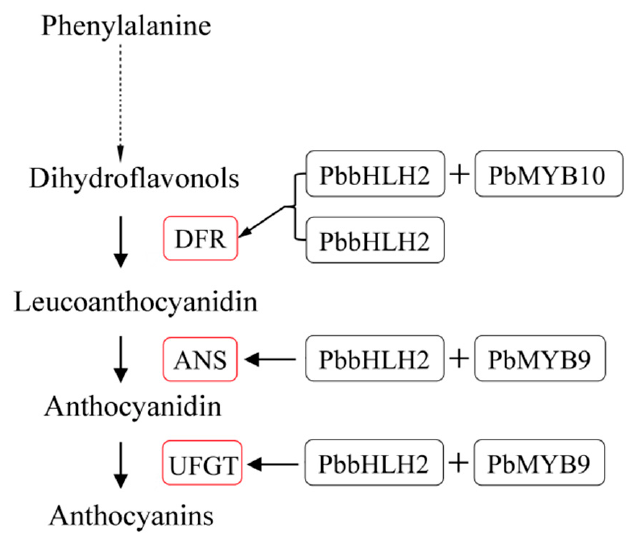
Figure 7. Proposed model for PbbHLH2 physical interaction, with or without PbMYB9 and PbMYB10, in the regulation of the anthocyanin biosynthetic pathway of pear. PbbHLH2 with or without PbMYB10 binds the promoter of PbDFR and up-regulates the gene’s expression. PbbHLH2 interacts with PbMYB9 to bind the PbANS and PbUFGT promoters and activate the genes’ expression. The red boxes indicate up-regulation.